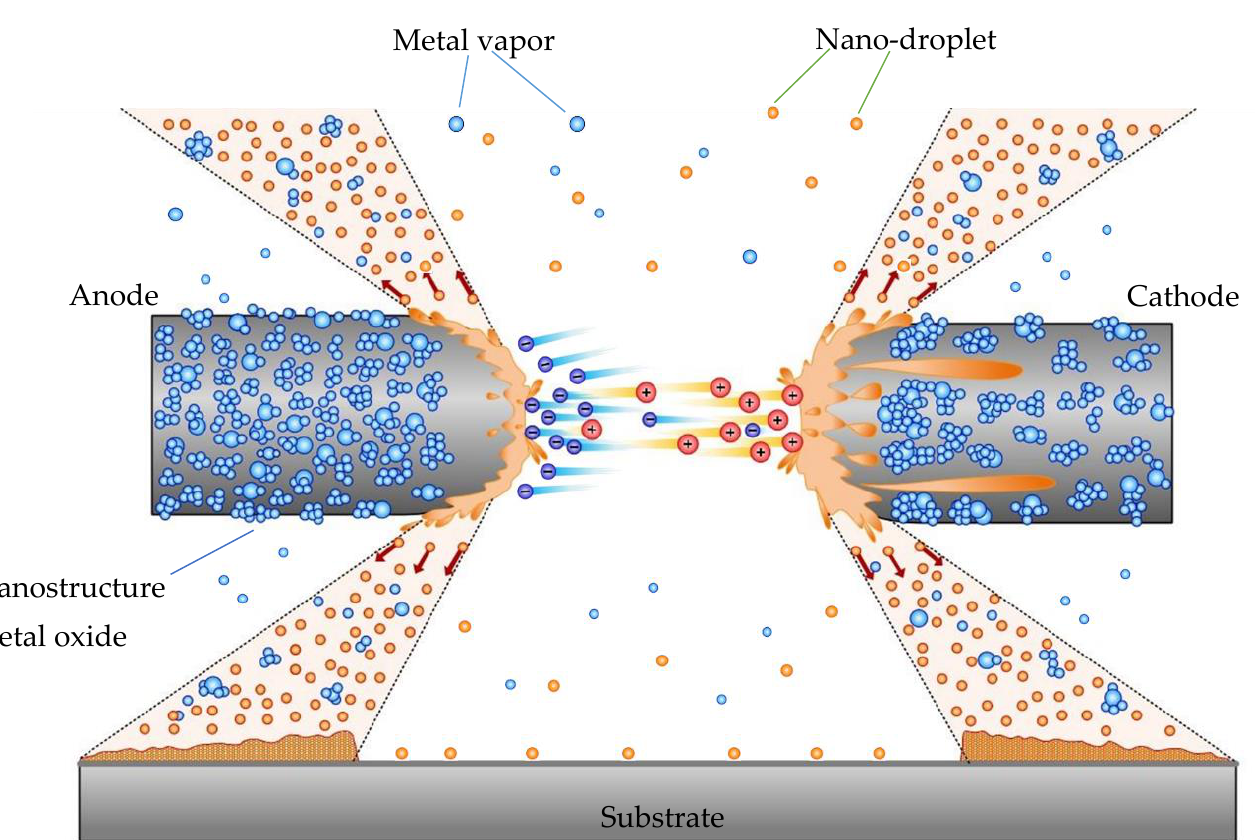
Figure 9. Schematic diagram of the nucleation mechanism of the nanostructure deposited by the sparking method.